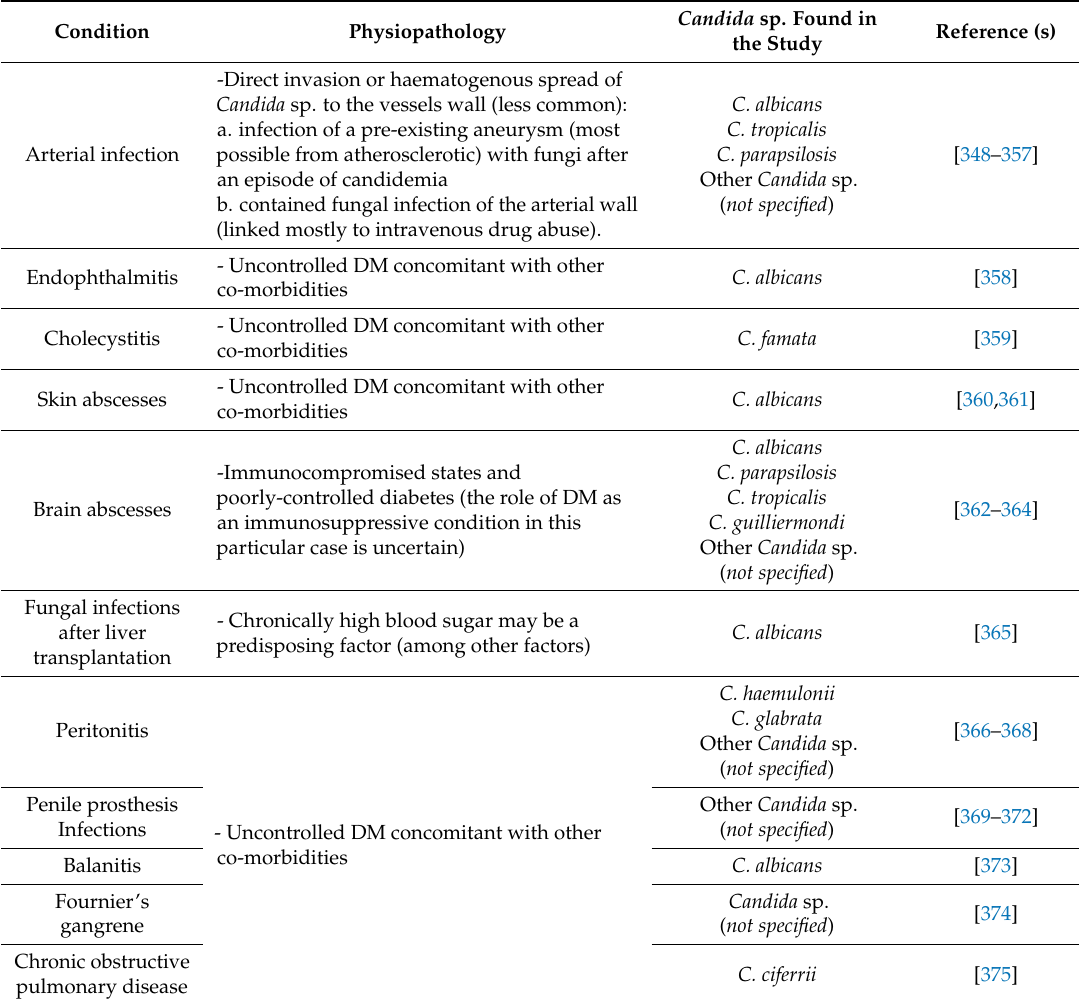
Table 5. Physiopathology and etiology related to the occurrence of other diseases linked to Candida sp. in